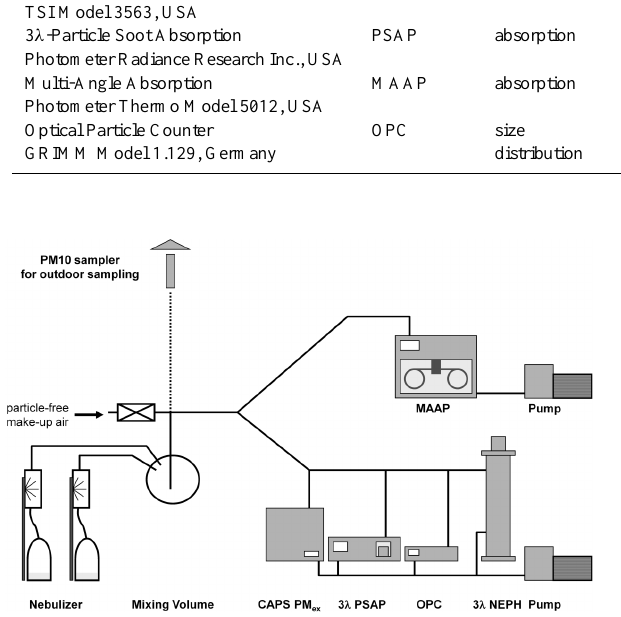
Fig. 2. Experimental set-up for the instrument evaluation using Figure 2. Experimental set-up for the instrument evaluation using polydisperse aerosol polydisperse aerosol mixtures of black carbon and ammonium sul- mixtures of black carbon and ammonium sulfate; the sampling line was switched to the fate; the sampling line was switched to the outdoor PM 10 sampler outdoor PM10 sampler (dashed line), for measuring ambient aerosol. (dashed line), for measuring ambient